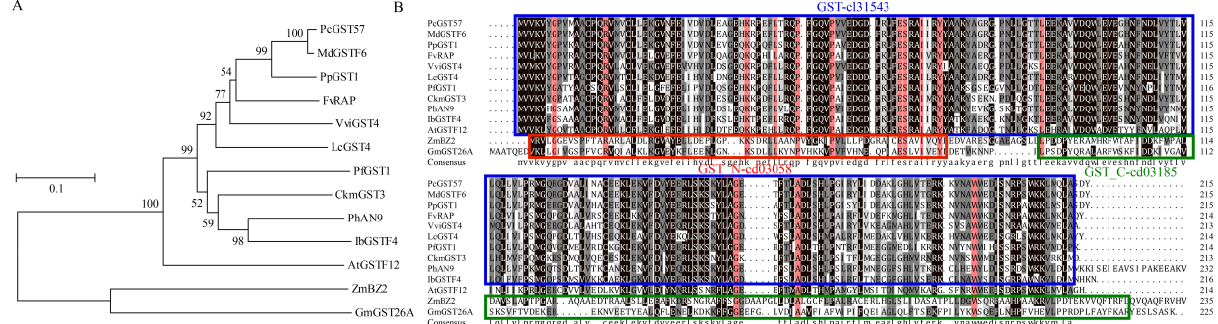
Figure 7. Phylogenetic analysis and sequence alignment of PcGST57 and its paralogs. ( A ) Phyloge- netic relationships of PcGST57 paralogs was shown by phylogenetic tree. GST proteins from Pyrus communis , Malus domestica , Arabidopsis , Prunus persica , Fragaria ananassa , and several other species were used for the construction of a neighbor-joining tree. ( B ) Sequence alignment of PcGST57 and its paralogs. The GST domain with accession number of cl31543 was indicated by blue box, the red box indicated as GST-N domain with accession number of cd03058, and green box indicated as GST-C domain with accession number of cd03185. The accession number of GST members used in the analysis were as follows, MdGSTF6 (MD17G1272100), PpGST1 (Prupe.3G013600.1), FvRAP (gene31672), VviGST4 (AAX81329), LcGST4 (ALY05893), PfGST1 (BAG14300), CkmGST3 (BAM14584), PhAN9 (CAA68993), IbGSTF4 (MG873448), AtGSTF12 (AED92398), ZmBZ2 (AAA50245), and GmGST26A